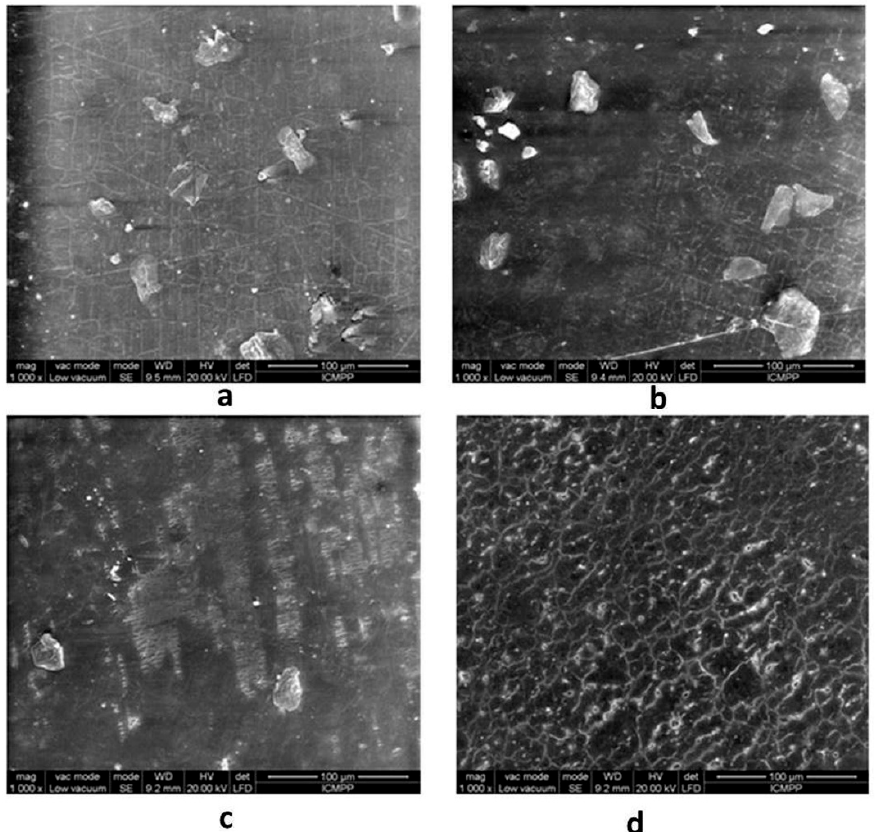
Figure 6. SEM micrographs of duodenoscope samples. a —1st sample, b —2nd sample, c —3rd sample, d —4th sample.